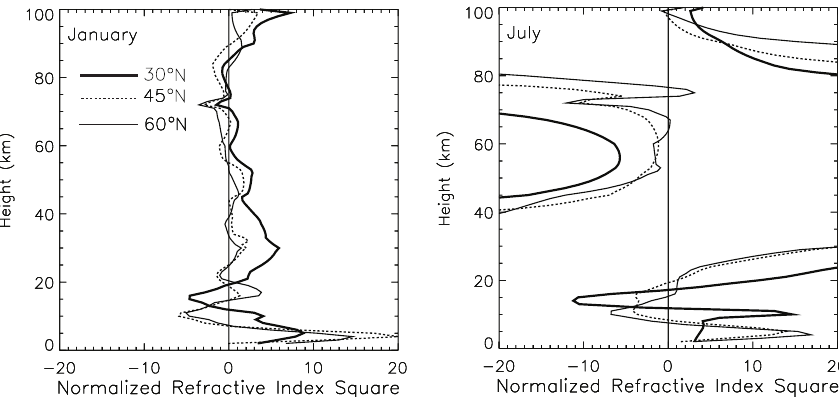
Fig. 11. The refractive index squares ( ν 2 ) for vertical propagation of the 16-day waves in January and July at latitudes of 30 ◦ , 45 ◦ , and 60 ◦ N, which are represented by thick solid, dotted, and thin solid lines,